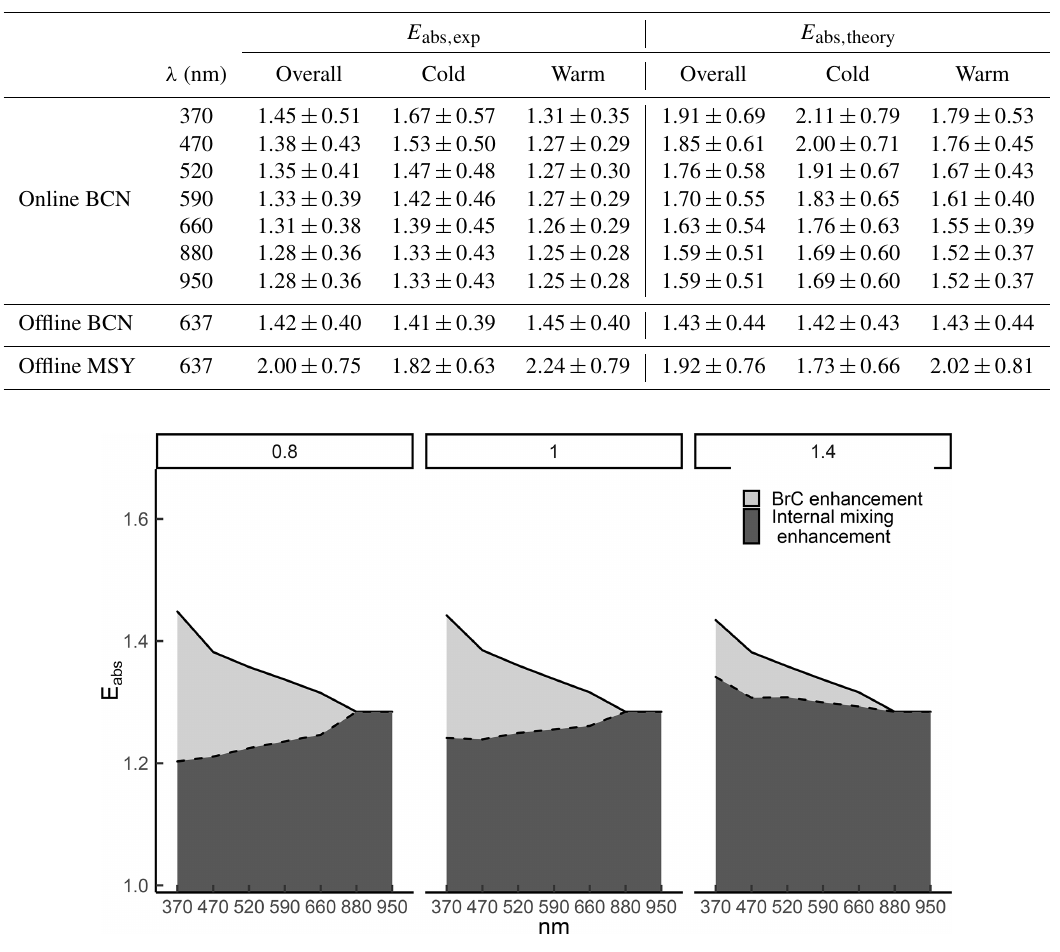
Table 2. Overall, and cold and warm period average E abs values for both multi-wavelength online measurements at BCN, and offline measurements at the near-infrared (NIR) BCN and MSY stations.